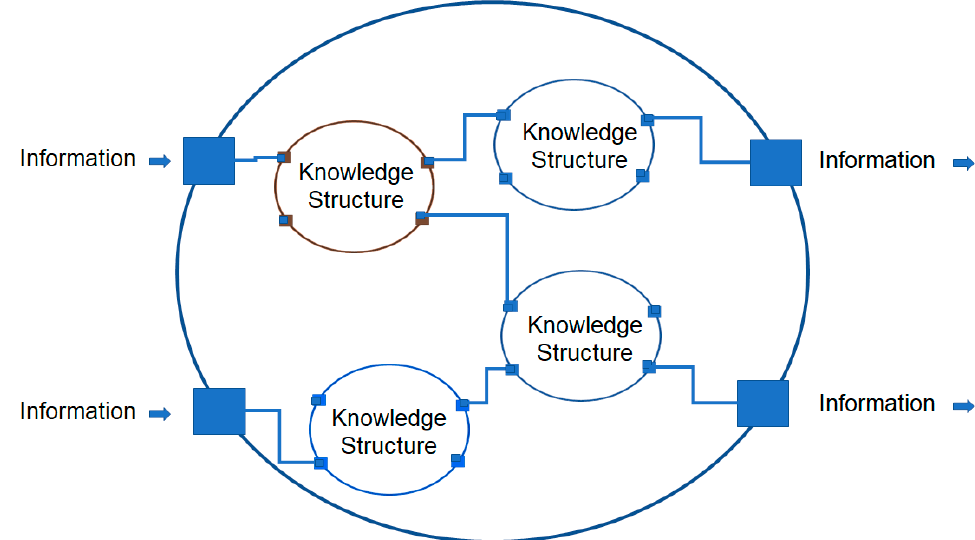
Figure 4. A knowledge network consisting of knowledge structures composed of fundamental triads representing knowledge.